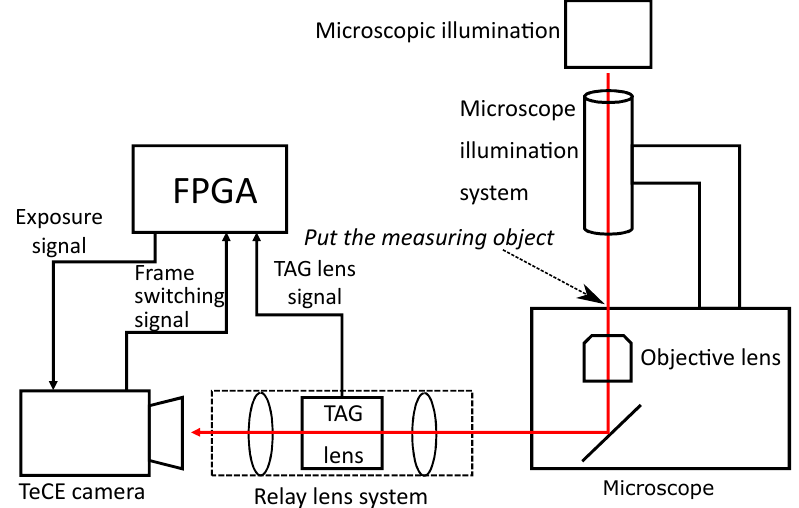
Figure 2. Configuration of experimental system. The field programmable gate array (FPGA) outputs an exposure signal that controls the exposure timing of the TeCE camera. The exposure signal is generated from the TAG lens signal and a frame switching signal. TAG lens signal indicates the trigger signal of the TAG